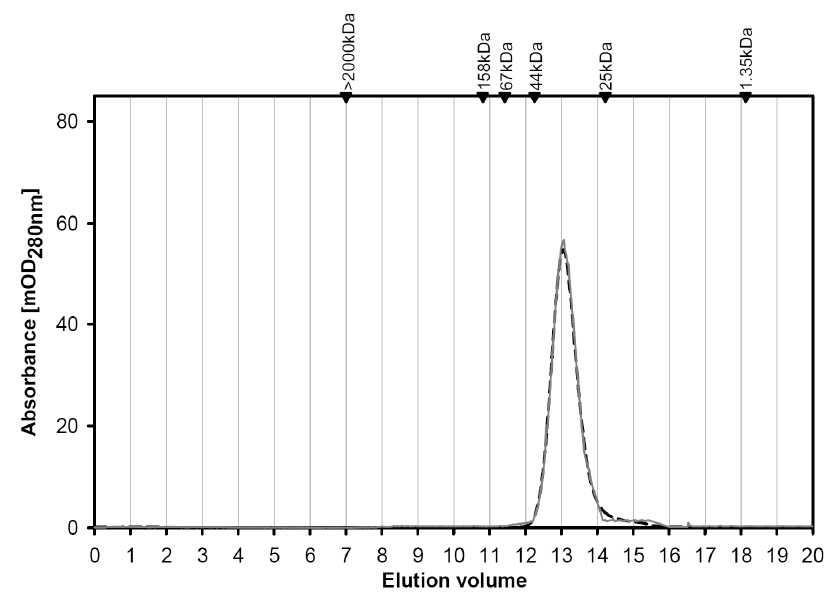
Figure 6. Elution profiles of Gal-8 (NN) during gel filtration in the absence and presence of 40 mM lactose. Black arrowheads mark positions of elution of molecular weight markers.